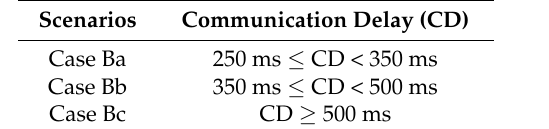
Table 3. Case scenarios for communication system performance.